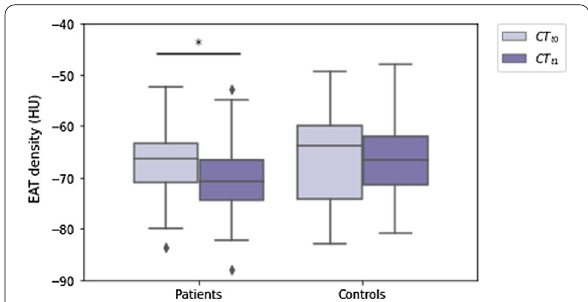
Fig. 3 Boxplots depicting the distributions of epicardial adipose tissue density at the first (CT-t 0 ) and second (CT-t 1 ) computed tomography examination in patients with breast cancer who underwent treatment with anthracyclines, and in controls with no breast cancer who did not undergo cardiotoxic treatment. * denotes statistical significance